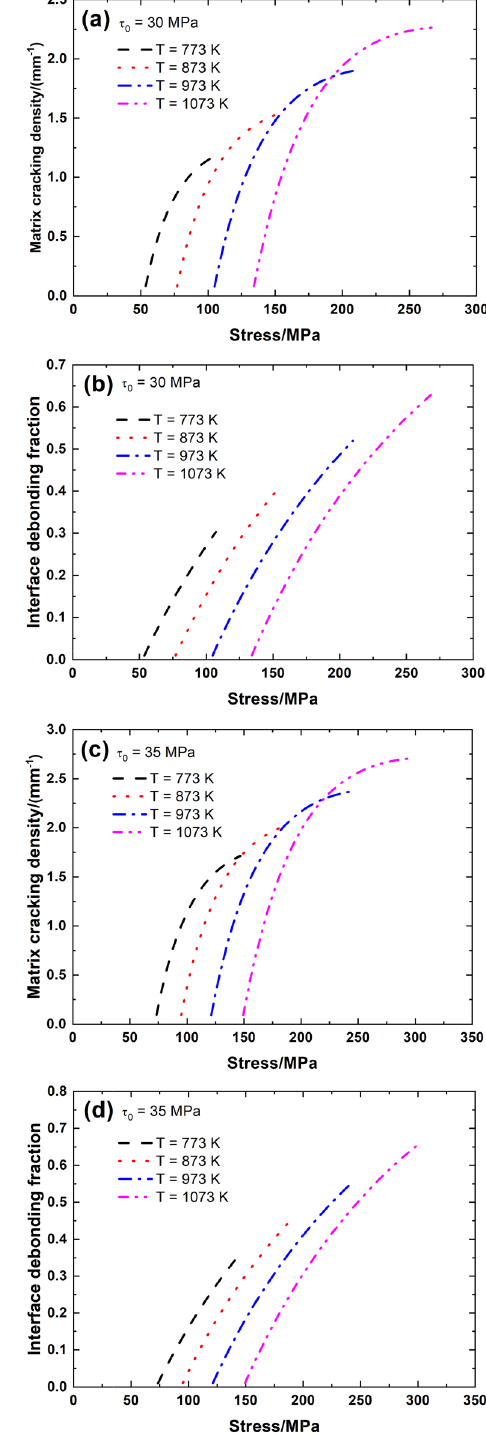
Figure 1: ( a ) The matrix multicracking density versus applied stress curves when τ 0 = 30 MPa; ( b ) the interface debonding fraction versus applied stress curves when τ 0 = 30 MPa; ( c ) the matrix multicracking density versus applied stress curves when τ 0 = 35 MPa; and ( d ) the interface debonding fraction versus applied stress curves when τ 0 = 35 MPa of C/SiC composites at elevated temperatures of T = 773, 873, 973, and 1,073